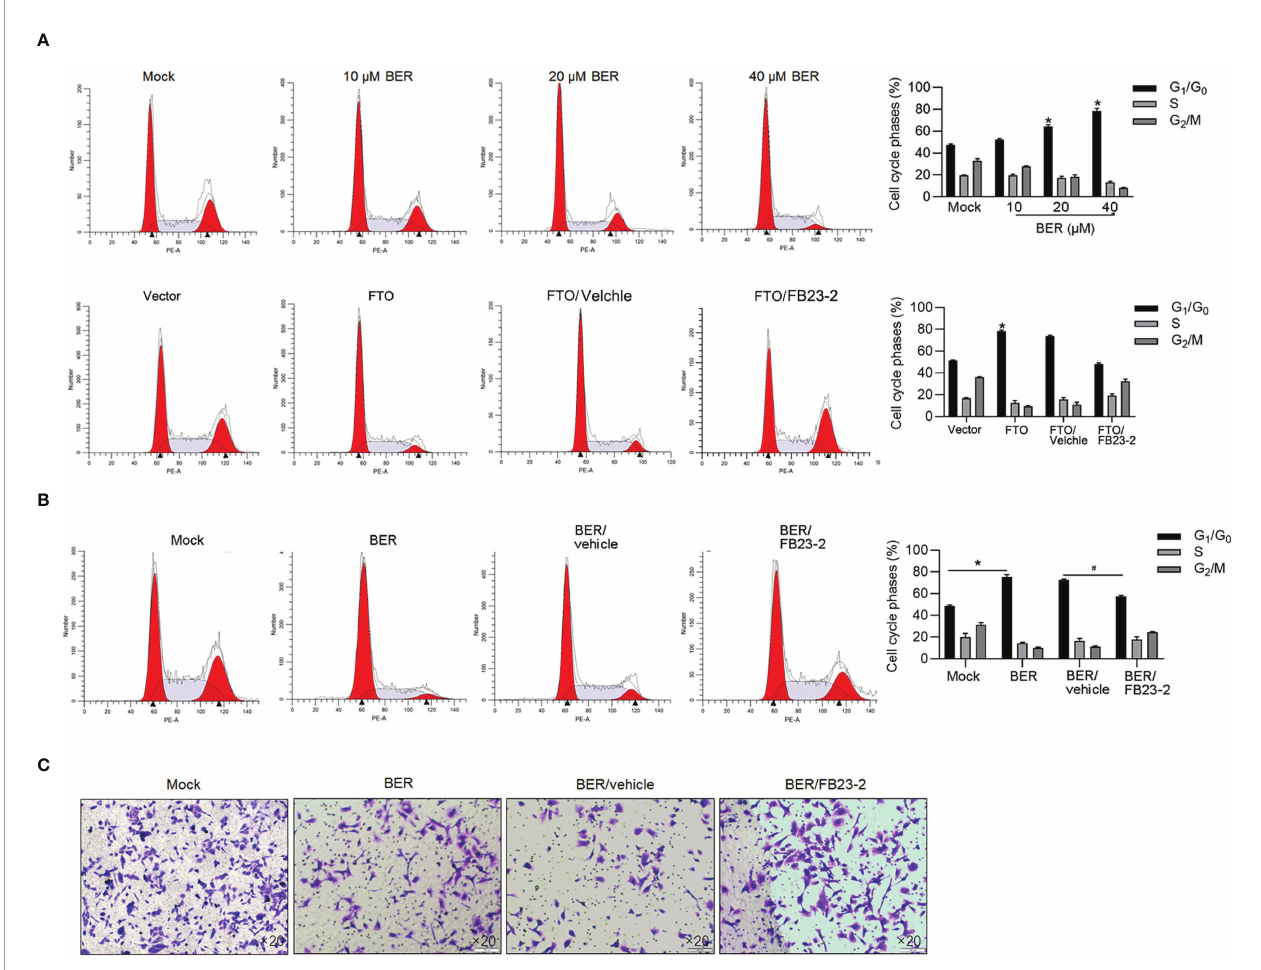
FIGURE 5 | Berberine blocked the cell cycle via upregulating FTO. The effects of Berberine on cell cycle distribution via FTO were con fi rmed by performing PI staining followed by fl ow cytometry (A, B) . *p < 0.05, vs. mock group; # p < 0.05, vs. BER/vehicle group. (C) Transwell assay was performed to detect invasive